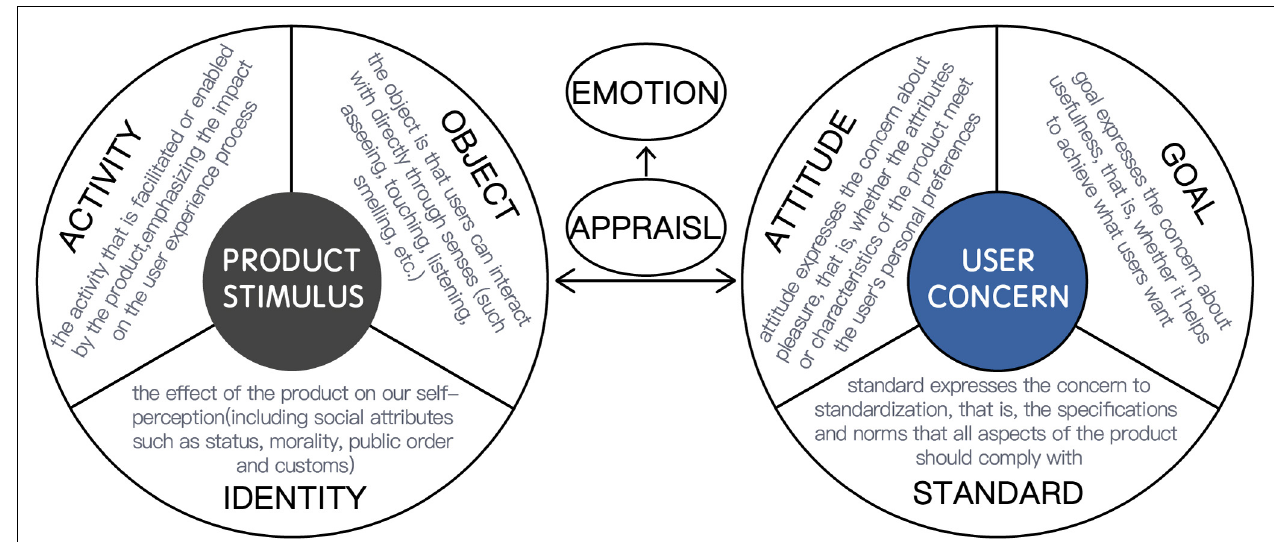
FIGURE 1 | Product emotion theory parameter